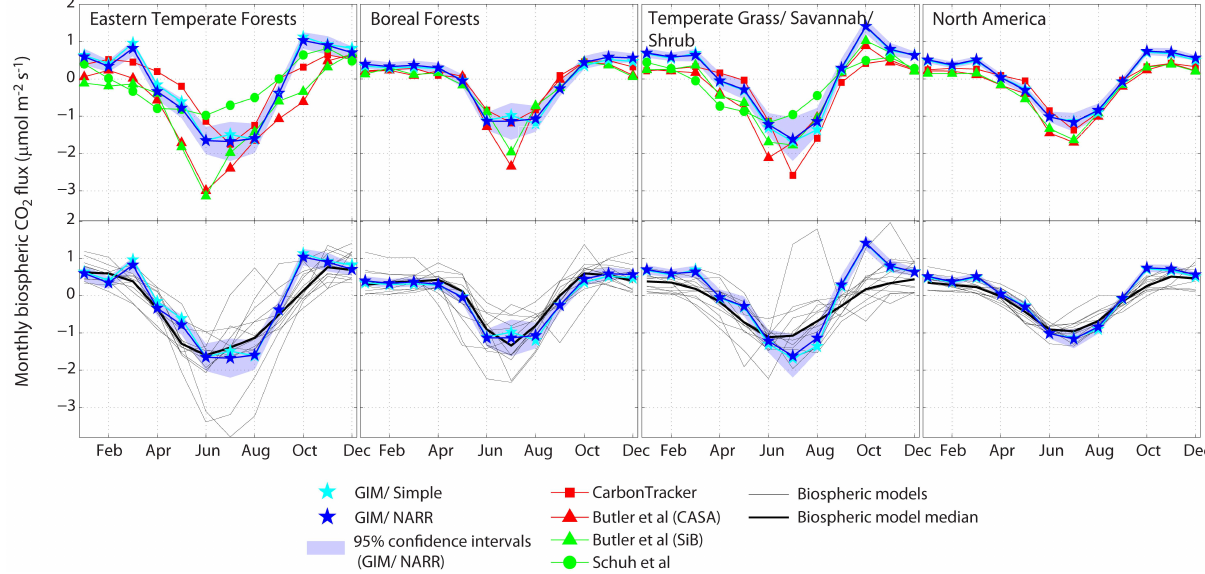
Fig. 5. Seasonal cycle of monthly-averaged fluxes aggregated to the three well-constrained ecoregions, as well as to the full continent (Fig. 2b). GIM fluxes using the EMP boundary conditions are compared to other inversions (top row) and individual biospheric models (bottom row) that have coverage in at least 85% of the given regions. Inversions with the same line color use similar biospheric model output for their prior flux